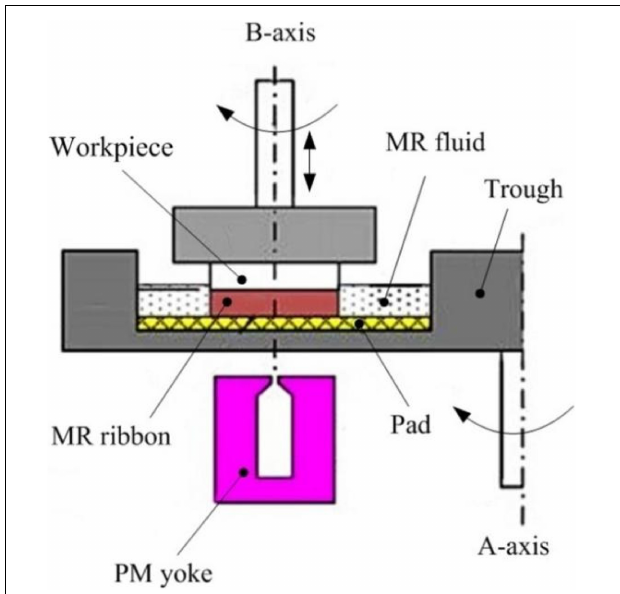
FIGURE 9 | Schematic diagram of magnetorheological plane polishing (Wang Y. et al., 2016).